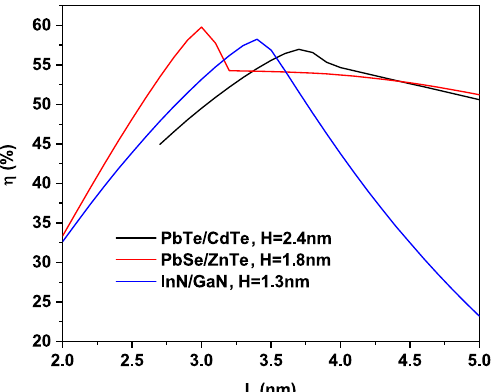
Figure 6. Photovoltaic conversion efficiency of QD-IBSC structure versus dot size L for different material systems and for a fixed inter-dot size at the optimum inter-dot spacing H = 2.4 nm, 1.8 nm and 1.3 nm for PbTe/CdTe, PbSe/ZnTe and InN/GaN QD materials.